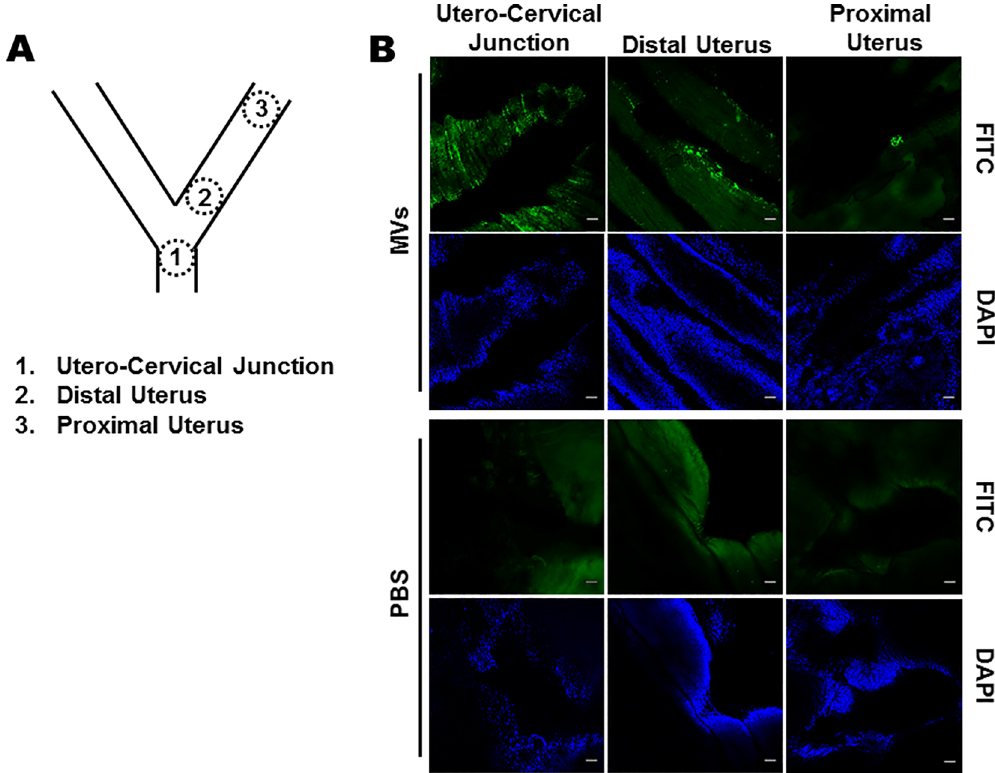
Fig 4. Anterograde transport of GBS MVs in female reproductive tract. A. Schematic diagram of female reproductive tract in mice. Areas denoted were visualized in the confocal microscope. B. FITC labelled GBS MVs (100 μ g) were vaginally instilled and the reproductive tract (cervix to uterus) were collected after 6 h. Tissues were briefly fixed in paraformaldehyde and visualized under a confocal microscope. Bright green fluorescent spots above the background auto flourescence (as estimated in PBS injected animals) were considered to be derived from MVs. The experiment was done thrice. Representative images at the utero-cervical junction, distal uterus and proximal uterus are shown. Corresponding DAPI stained images are also shown. Scale bar; 50 μ